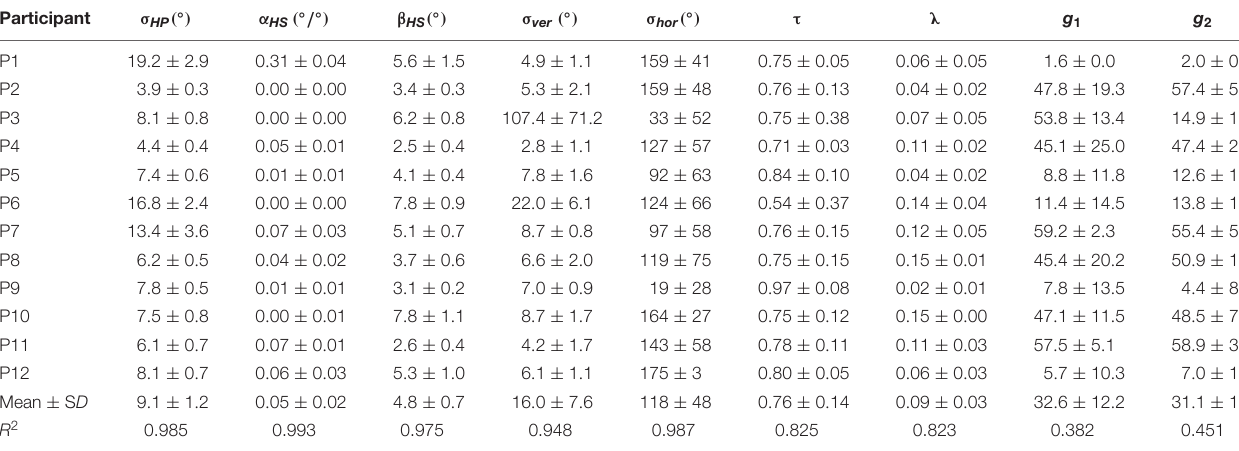
TABLE 2 | Parameter values of the model, including a measure of how well the parameter values could be recovered ( R 2 ). Participant